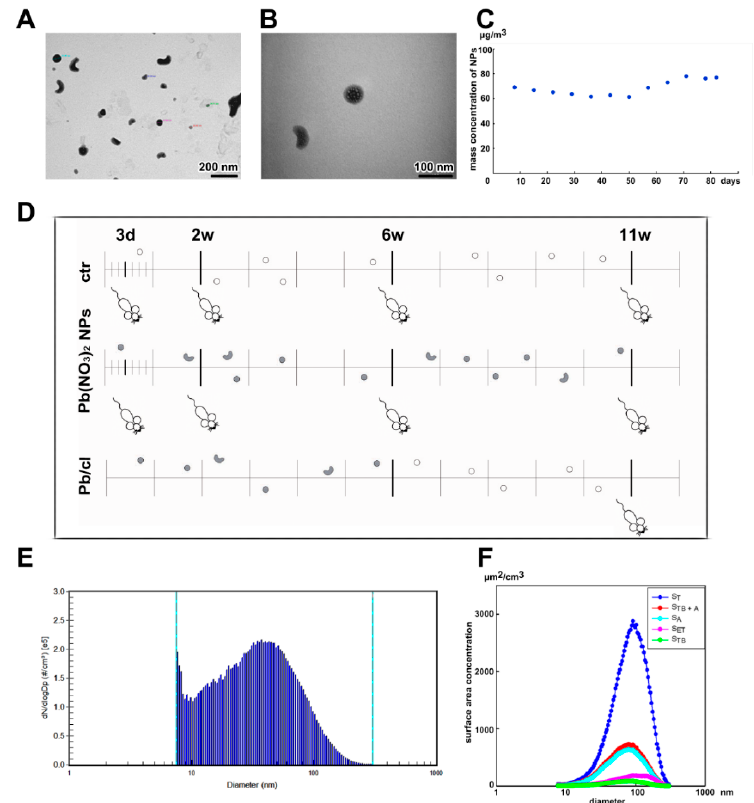
Figure 1. The characterization of Pb(NO 3 ) 2 nanoparticles (NPs) in the inhalation chambers, and the scheme of overall experimental design. ( A , B ) The characterization of Pb(NO 3 ) 2 NPs analyzed in the